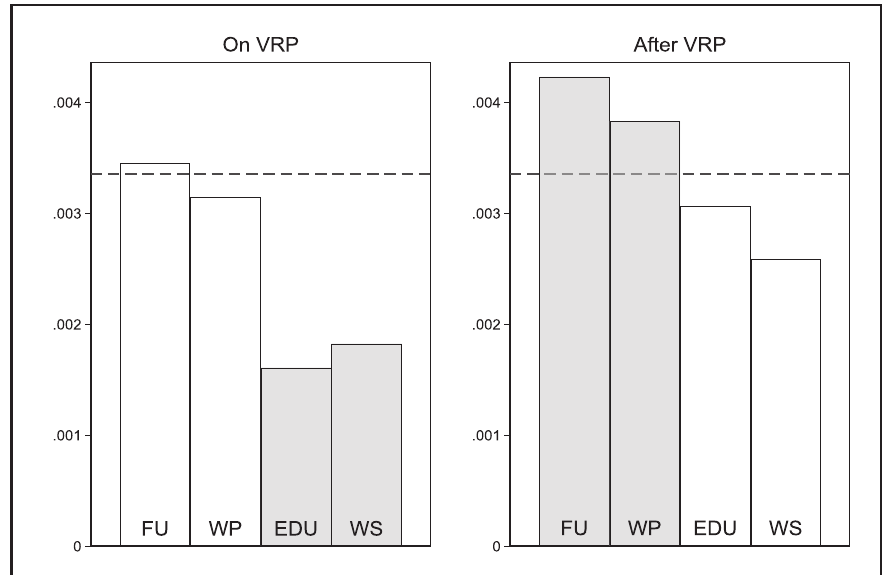
Figure 5 The effect of vocational rehabilitation program (VRP) on the transition to social